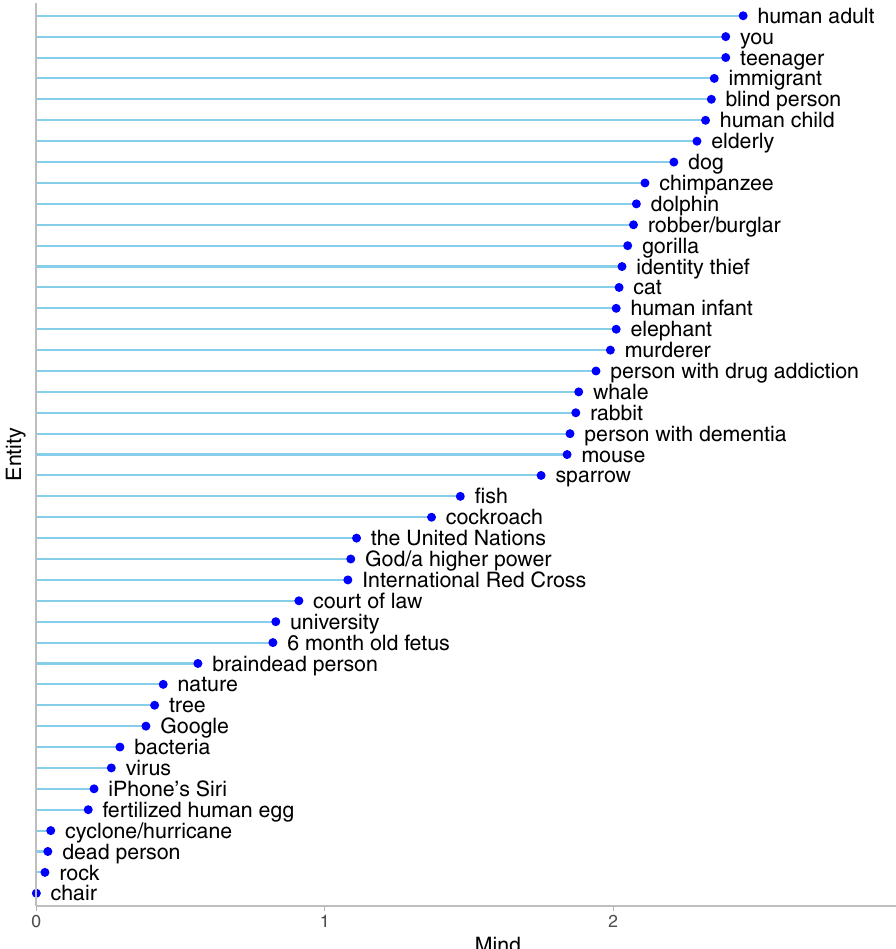
Figure 1. Distribution of entities along the single dimension of mind. The lines represent the average regression weights for entities from Study 3, scaled such that the lowest value corresponds to 0. A longer line represents more ascription of mind (e.g., “adult”) whereas a shorter line represents less ascription of mind (e.g.,